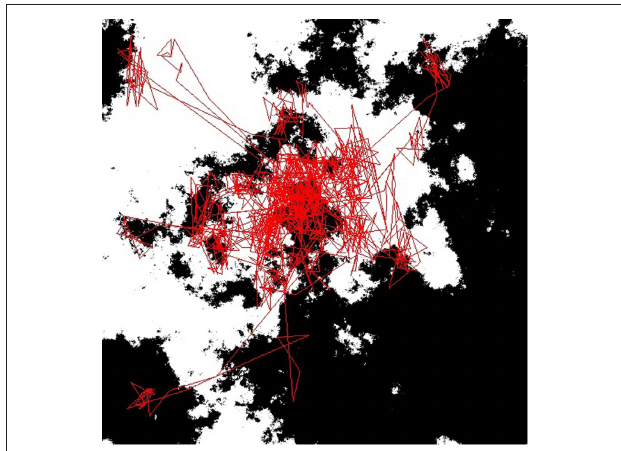
FiGurE 6 | An example of the computer-generated fractals (black and white) viewed by the subjects for the eye-tracking results shown in Table 2. The red lines are the eye trajectories.